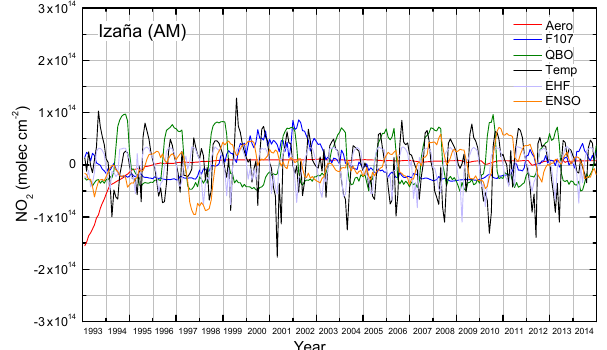
Figure 3. Example of the contributions of the proxies other than the seasonality and trends to the modelled NO 2 time series for